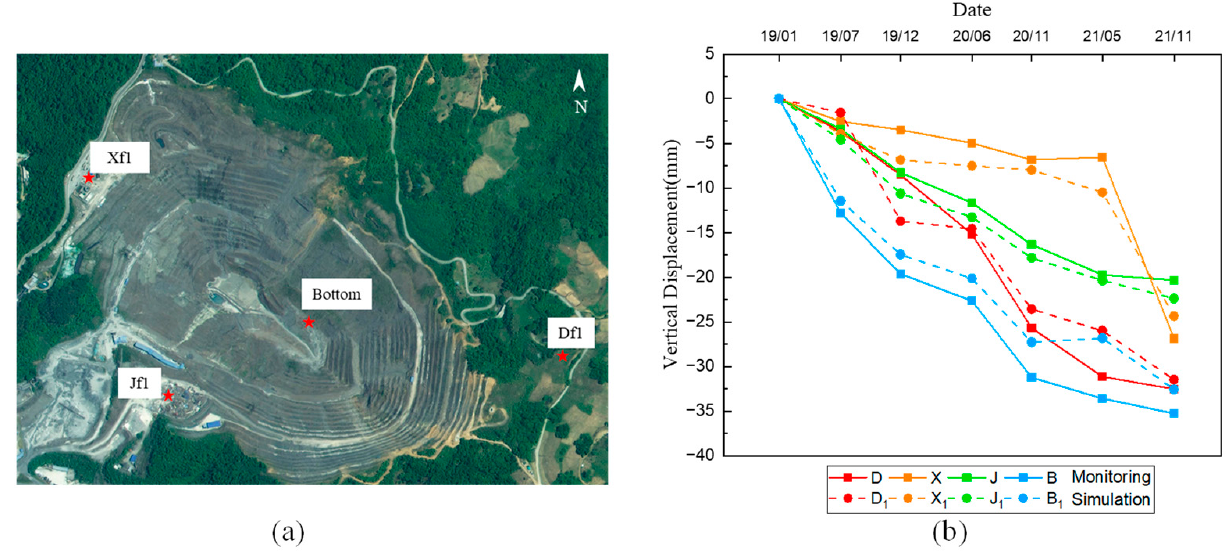
Figure 11. Underground mining sequence.